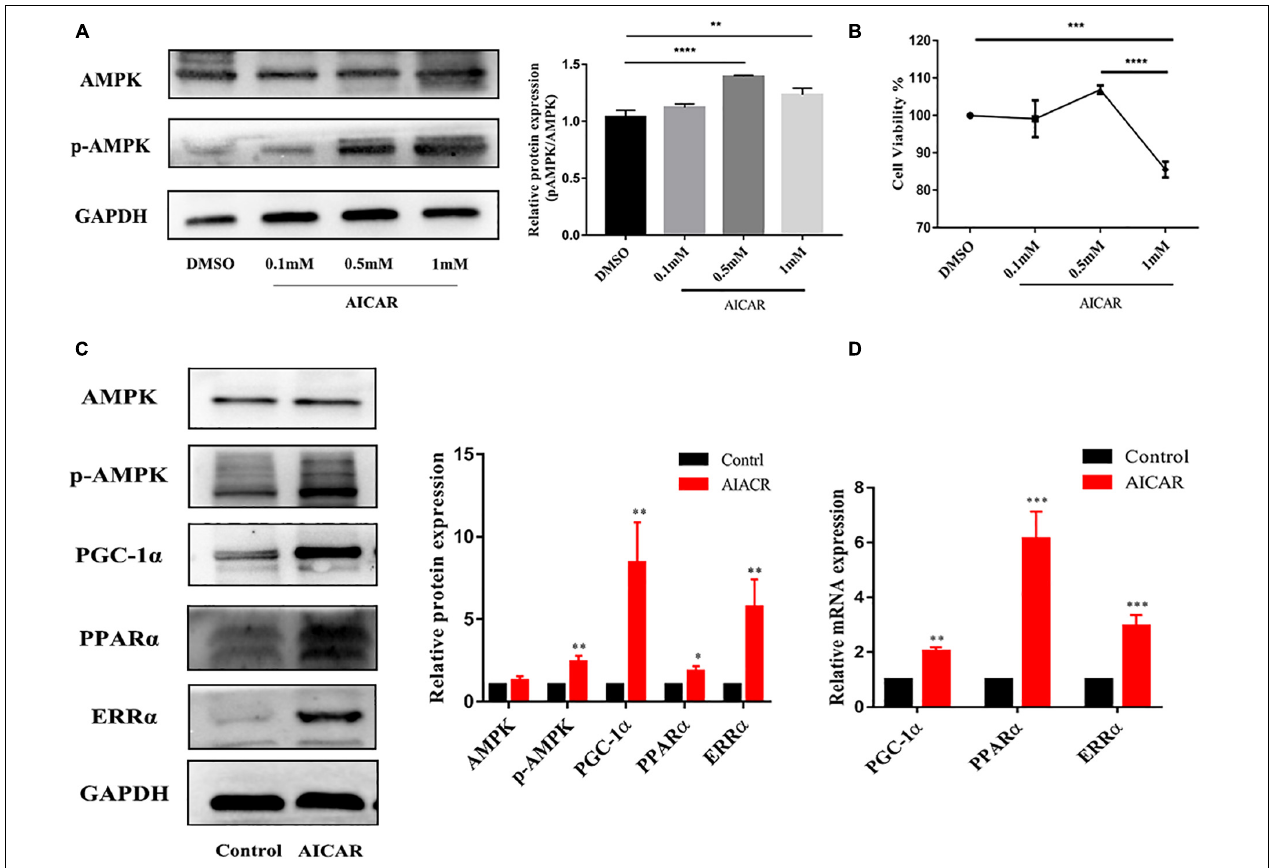
FIGURE 3 | Activation of AMPK improved the metabolic maturation of hiPSC-CMs. (A) Western blot analysis of AMPK and phospho-AMPK expression in hiPSC-CMs treated with AICAR at various concentrations (0, 0.1, 0.5, and 1 mM). AICAR (0.5 and 1 mM) effectively upregulated the expression of phospho-AMPK ( n = 3). (B) CCK-8 assay was performed to assess viability of hiPSC-CMs treated with AICAR at various concentrations ( n = 3). ** P < 0.01, *** P < 0.001, **** P < 0.0001 one-way ANOVA. (C) Western blot analysis of the effect of AMPK activation by AICAR on the protein expression levels of AMPK, p-AMPK, PGC-1 α , PPAR α , and ERR α ( n = 3). (D) RT-qPCR analysis of the effect of AMPK activation by AICAR on the mRNA expression levels of PGC-1 α , PPAR α , and ERR α ( n = 3). * P < 0.05, ** P < 0.01, *** P < 0.001 compared with the control group, unpaired t